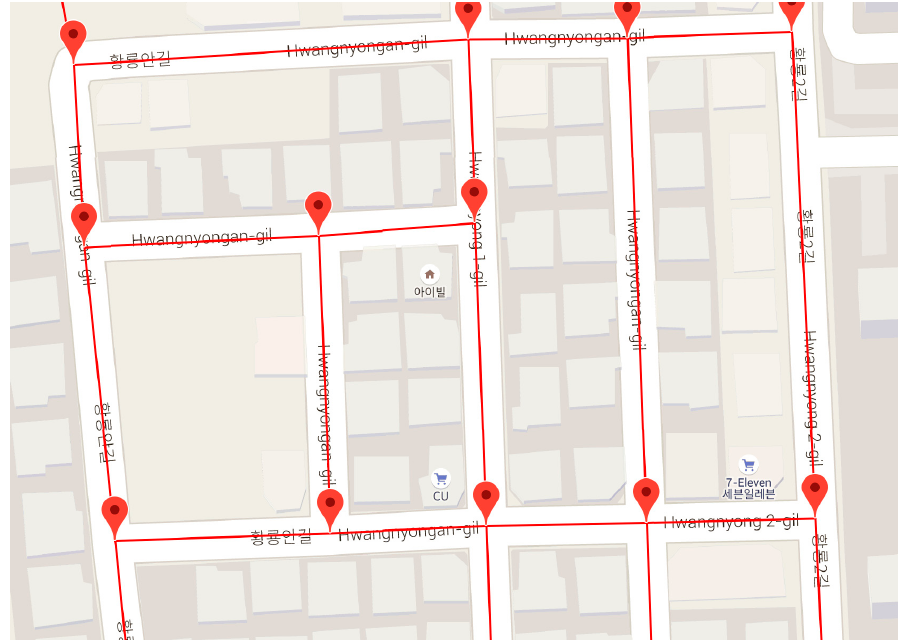
Figure 1. Expressed road segments on a map.